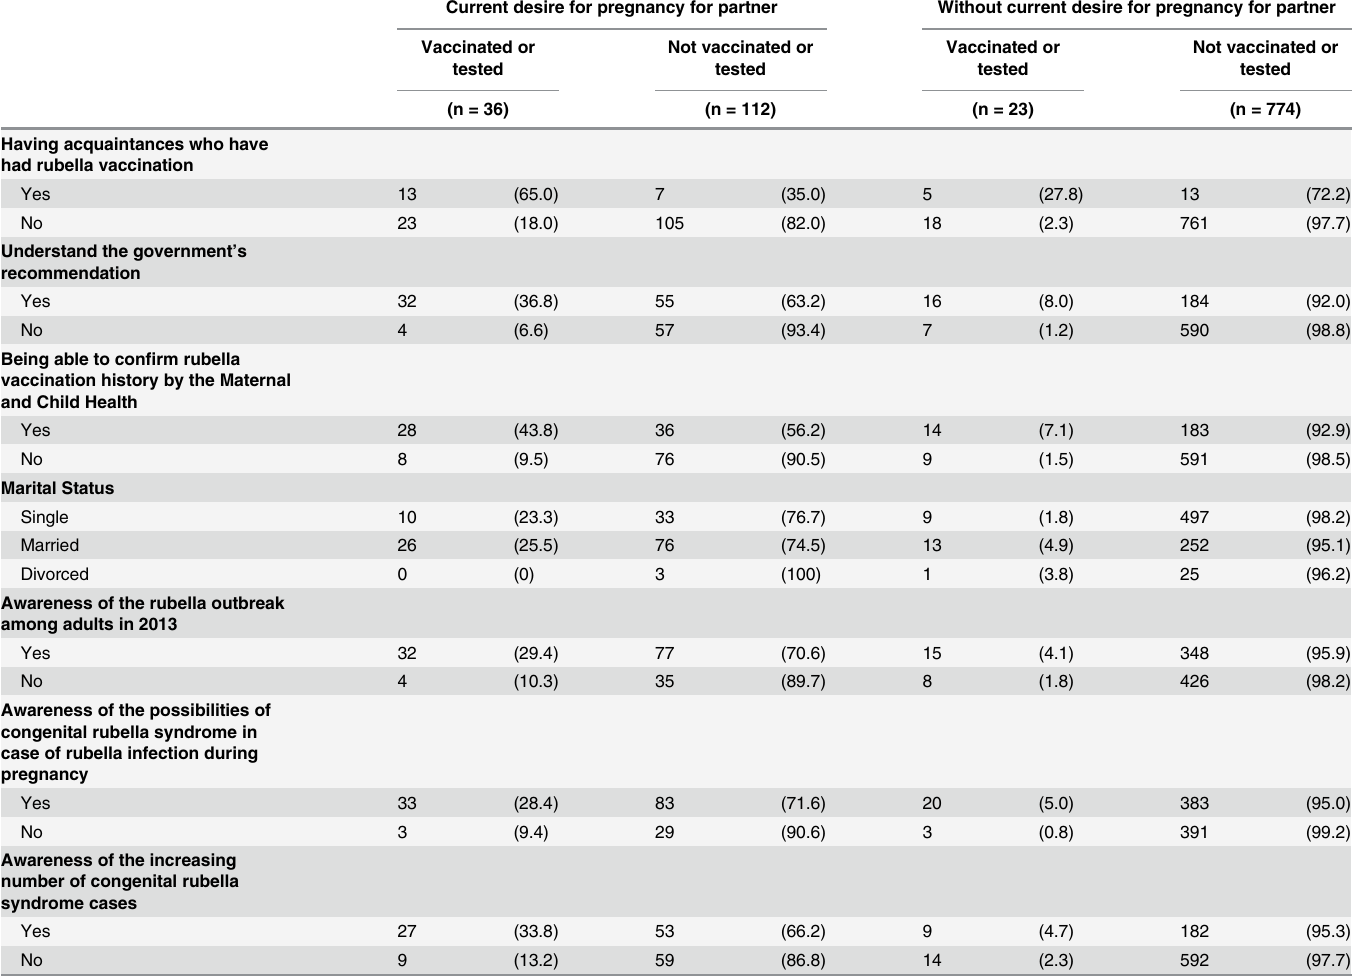
Table 4. Vaccination or antibody testing for rubella in 2013 for